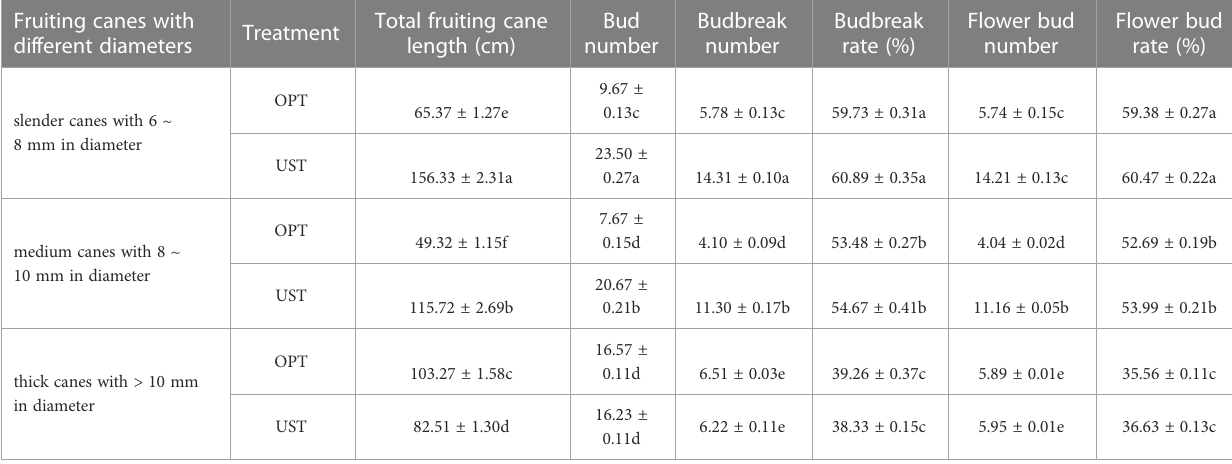
TABLE 5 Effects of the OPT and UST on fruiting canes of Donghong kiwifruit. Fruiting canes with different diameters